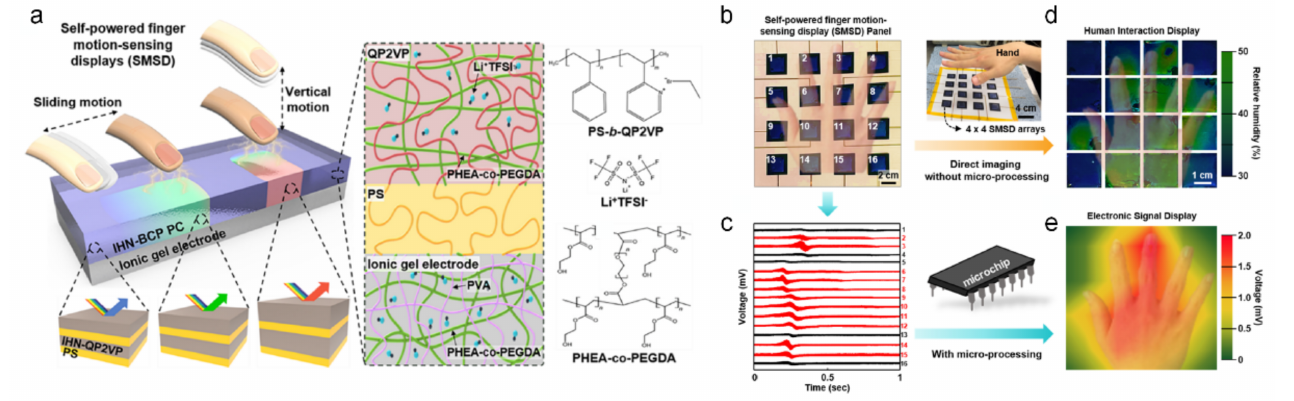
Figure 9. ( a ) Schematic illustration of the self-powered finger-motion-sensing display (SMSD) based on an IHN-BCP film on an ionic gel electrode, and touchless motion sensing showing the color change in the IHN-BCP layer. ( b ) The photograph of 4 × 4 arrays of the SMSDs on a flexible 20 × 20 cm 2 substrate. ( c ) The voltage signals of the SMSD panel according to the hand motion. ( d ) Two-dimensional contour plot mapping of the voltage signal. ( e ) Images of the structural color of the IHN-BCP from touchless hand motion. ( a – e ) adapted with permission from ref. [111], copyright 2022